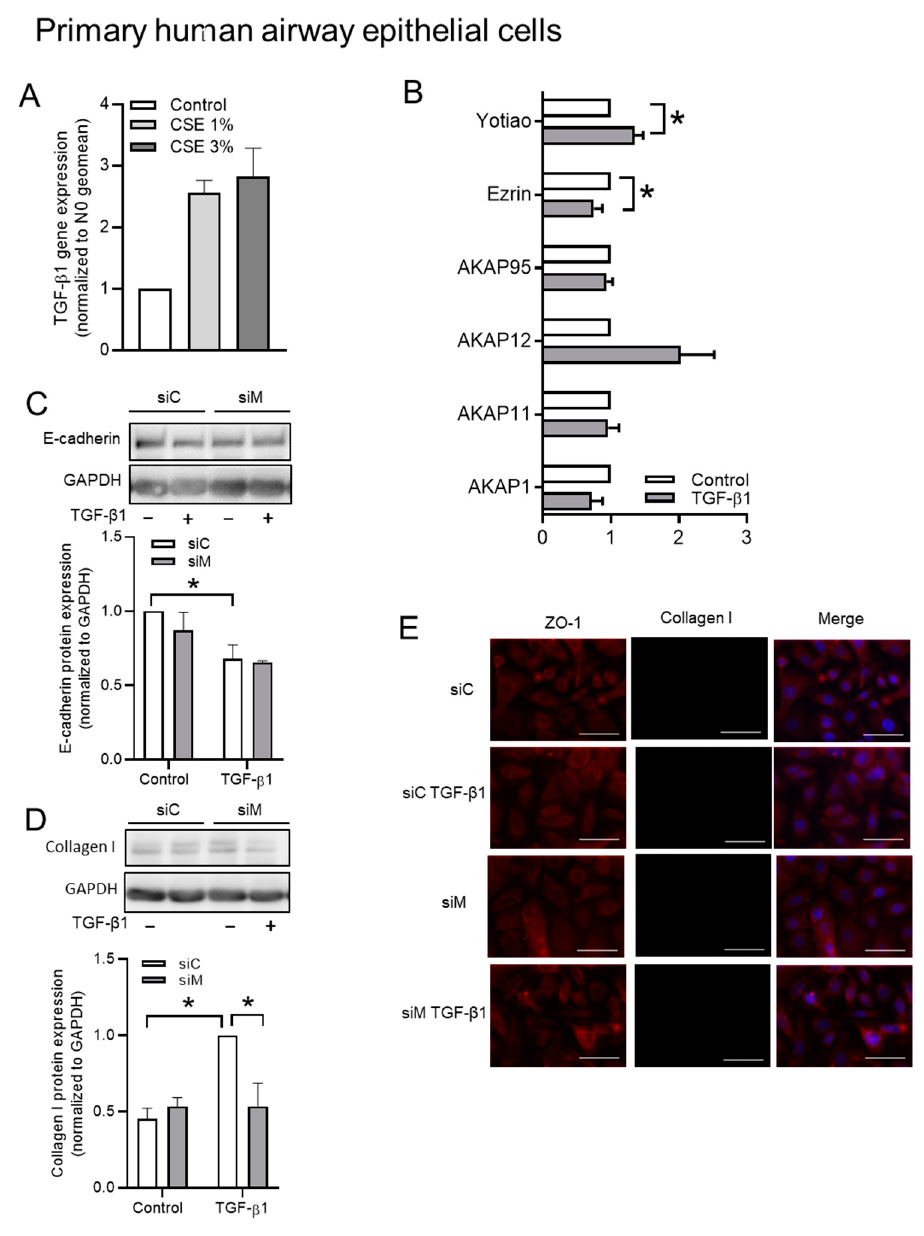
Figure 8. The effect of CS extract on TGF- β 1 mRNA release, the effect of TGF- β 1 on TGF- β 1-induced EMT in pHAE cells. ( A ) TGF- β 1 mRNA was measured of cells exposed for 24 h to the indicated CSE concentrations. ( B ) Gene expressions of AKAP1 , AKAP11 , AKAP12 , AKAP95 , Ezrin , and Yotiao were studied by real-time quantitative PCR. ( C , D ) Protein expressions of E-cadherin and collagen I were analyzed in pHAE cells were transfected with a combination siRNA of Ezrin, AKAP95, and Yotiao together with 3 ng/mL TGF- β 1. ( E ) Representative immunofluorescence images of EMT markers in pHAE cells after TGF- β 1 stimulation for 24 h. The data represent 3–5 independent experiments. Data are expressed as mean ± SEM, * p < 0.05; significant difference between indicated groups.